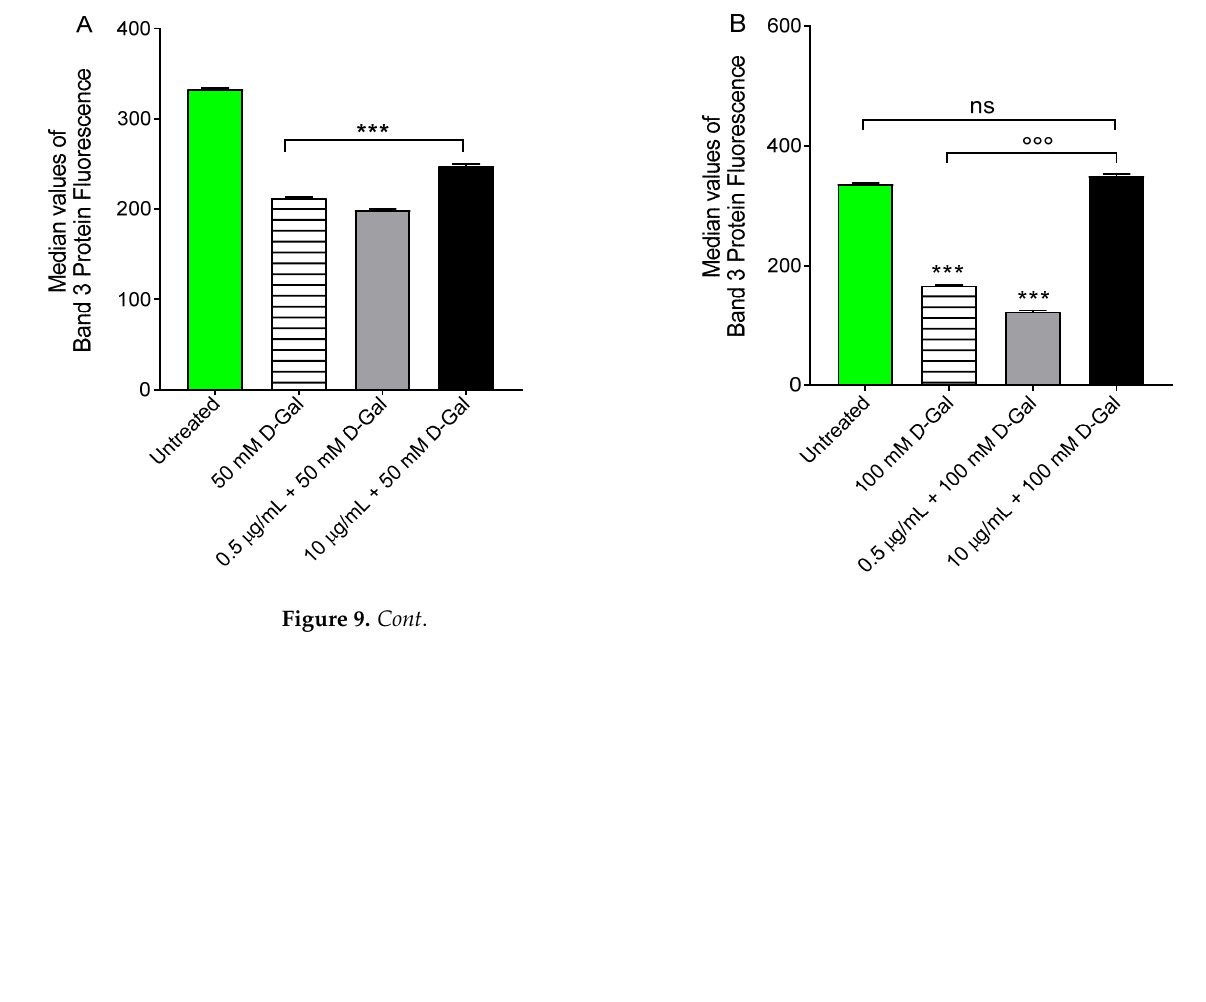
Figure 8. Flow cytometry immunofluorescence of CD47 protein expression. Erythrocytes were treated for 24 h with 50 ( A ) or 100 mM ( B ) D -Gal, with or without pre-incubation for 1 h with 0.5 or 10 µ g/mL freeze-dried Aça ì extract. Histograms represent median values of fluorescence intensity. In ( C , D ), typical flow cytometry measurements of CD47 expression of a representative experiment are shown. In ( E ), representative images of CD47 expression obtained by flow cytometry immunofluorescence are shown. Samples were observed with a 100 × objective. Note the significant morphological changes in both 50 and 100 mM d-Gal (arrows). ns, not statistically significant versus control; ***, p < 0.001 versus control; ◦◦◦ , p < 0.001 versus 50 or 100 mM d-Gal, one-way ANOVA followed by Bonferroni’s post hoc test ( n = 8).